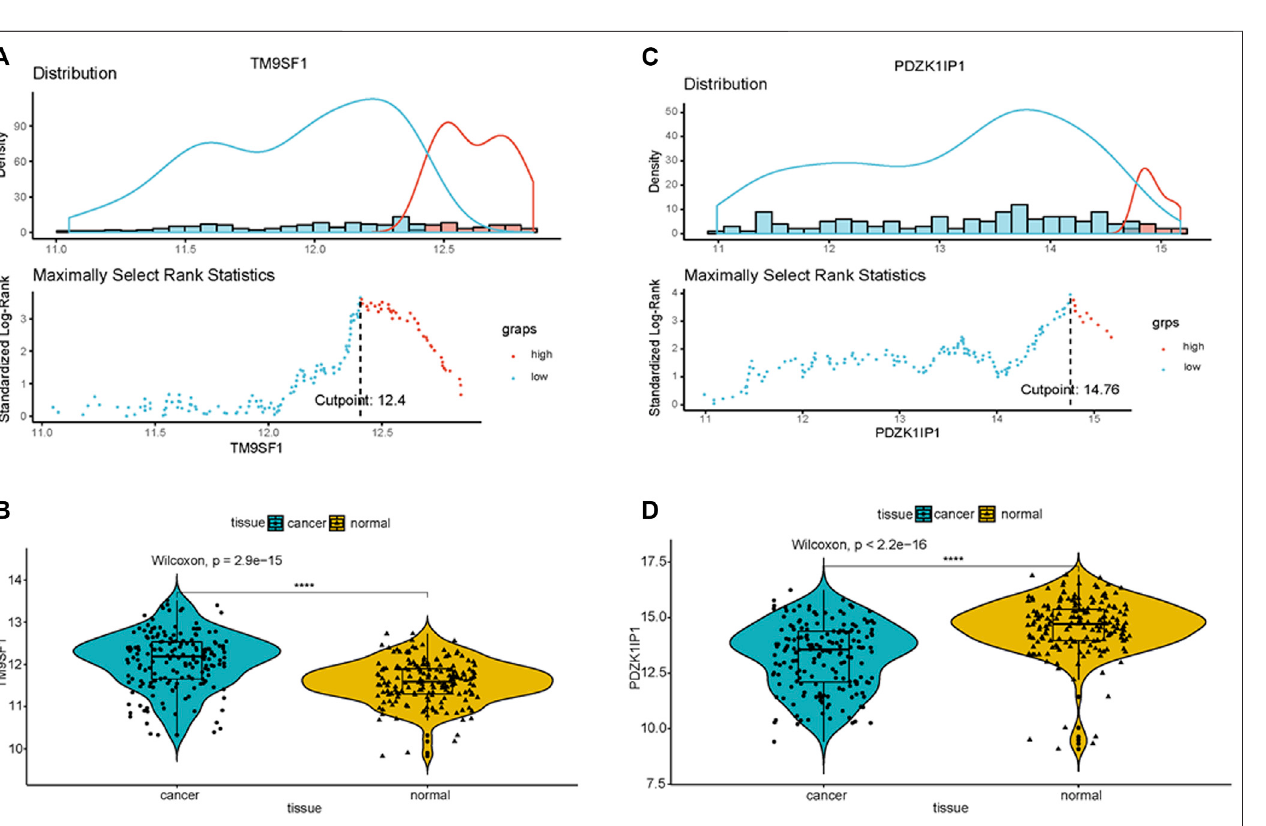
Frontiers in Bioengineering and Biotechnology |